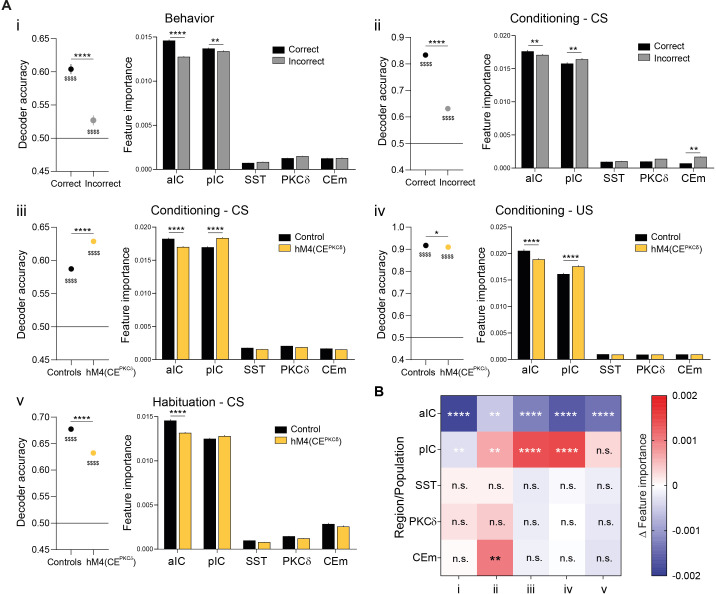
Pavlovian learning task stimulus distributions in the IC–CE network are reshaped by performance and CEPKCδ.(A) RF Da (left) and associated feature importance distribution (right) for (i) correct/incorrect behavior during conditioning and recall (one-way ANOVA, F9,156190=5184.00, p<0.0001), (ii) correct/incorrect CS in conditioning (one-way ANOVA, F9,73454=2437.00, p<0.0001), (iii) CS in conditioning (one-way ANOVA, F9,77790=5185.00, p<0.0001), (iv) US in conditioning (one-way ANOVA, F9,77821=2126.00, p<0.0001) and (v) CS in habituation for control and hM4(CEPKCδ) conditions (one-way ANOVA, F9,77619=1766.00, p<0.0001). For Da, * indicates a significant difference as determined by two-sample t-tests, $ indicates a significant difference as determined by one-sample t-tests to random (0.5). For feature importance, Holm-Sidak post hoc was used for all analyses. *p<0.05, **p<0.01, ****/$$$$p<0.0001. (B) Summary of differential feature importance between conditions. Colors were used for all TE network projections.